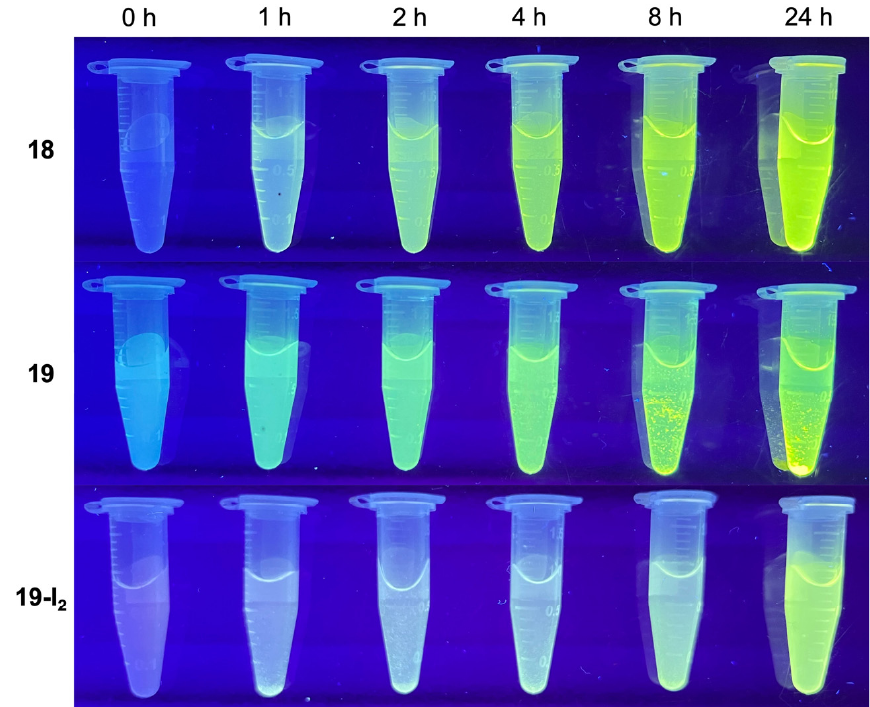
Figure 8. Visualization (UV illumination) upon treatment with PDE (20 μ g/mL) under physiological condition (pH 7.0 and 37 °C) over time with substrates 18 ( top row ), 19 ( middle row ), and 19-I 2 ( bottom row ), each at 20 μ M.